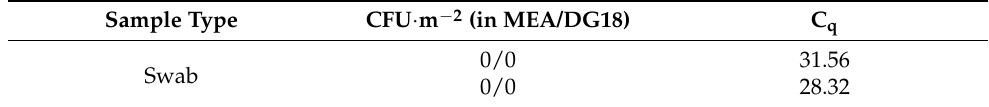
Table 4. Molecular detection of Aspergillus section Fumigati .